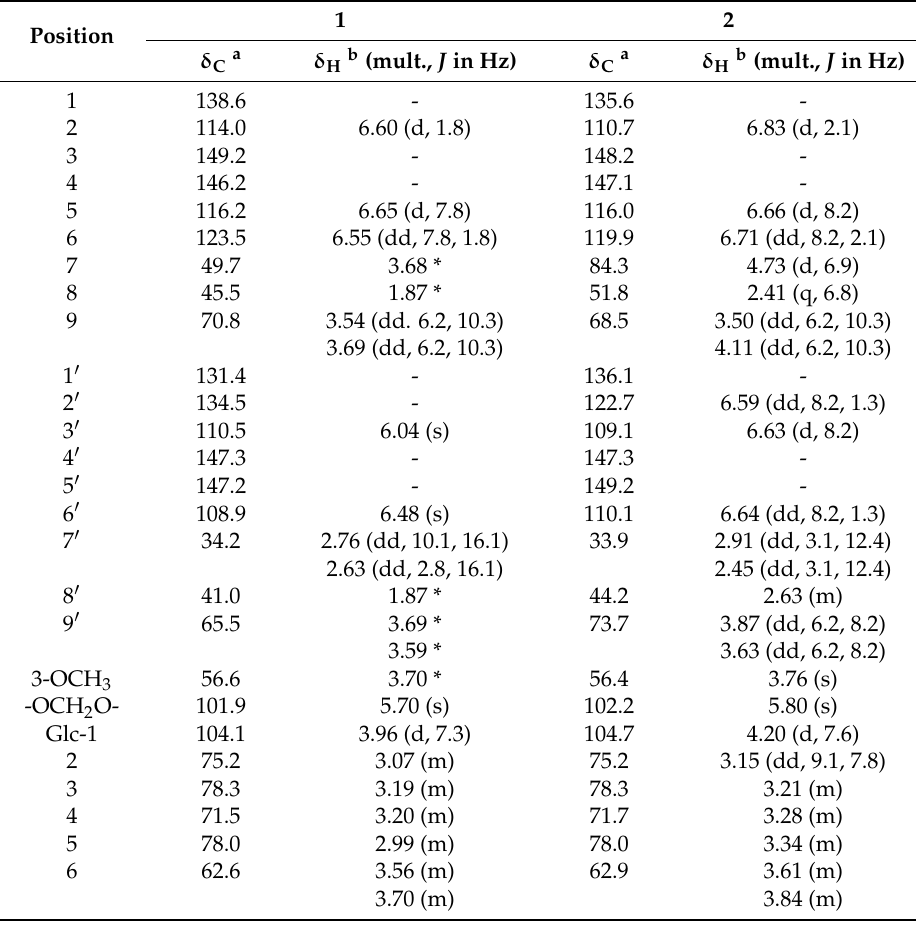
Table 1. 1 H- and 13 C-NMR spectroscopic data of compounds 1 and 2 in CD 3